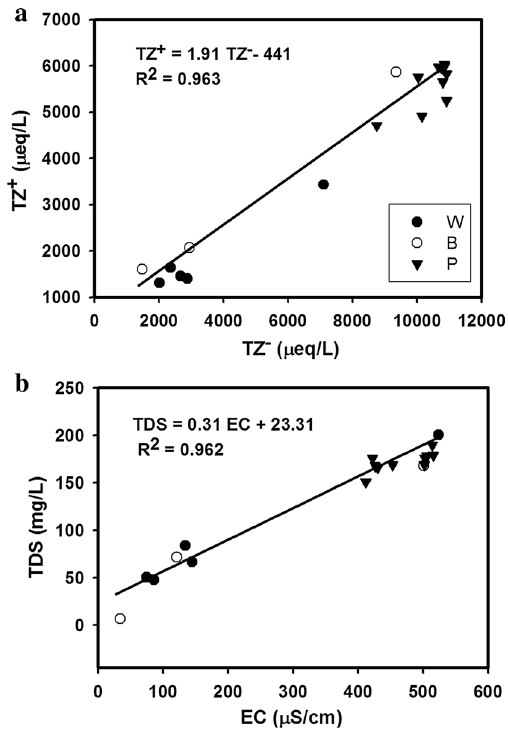
Fig. 2 a Relationship of total anions (TZ − ) to total cations (TZ + ) of the groundwater samples; b relationship of electrical conductivity (EC) to total dissolved solids